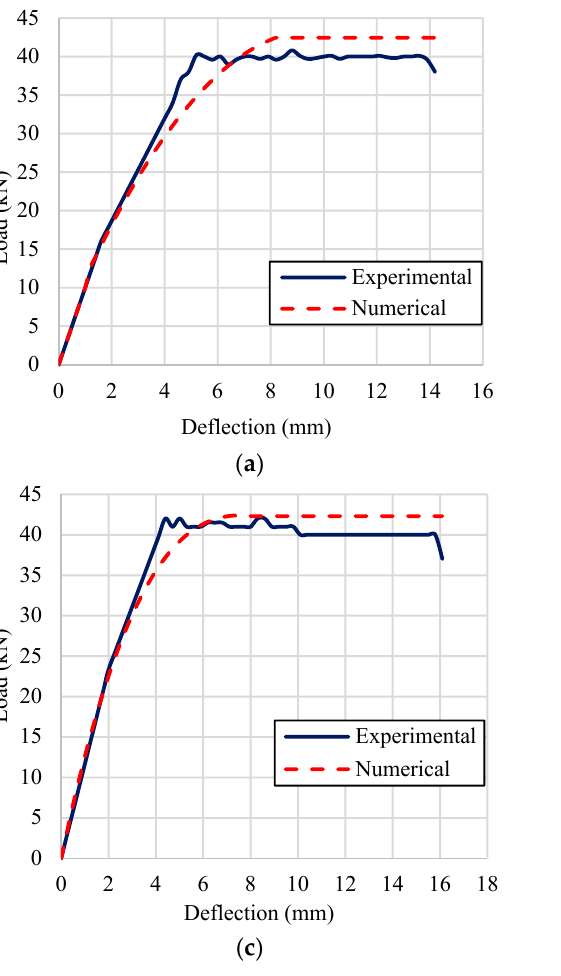
Figure 11. Comparison of load–deflection curves between experimental and numerical for beam ( a ) CRT-0, ( b ) CRT-10, ( c ) CRT-20, and ( d ) CRT-30.